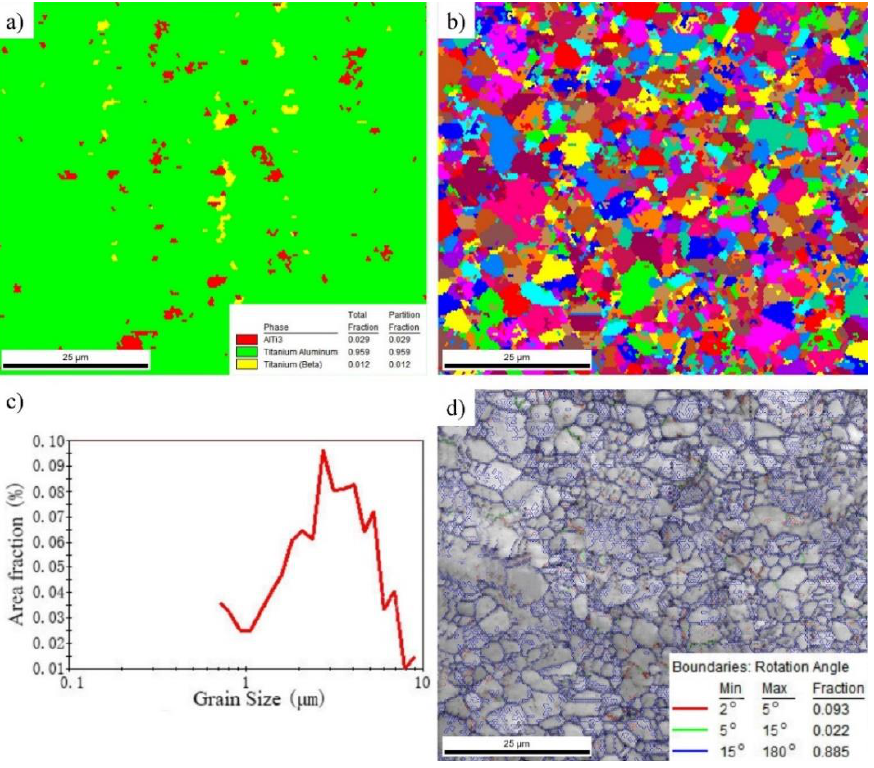
Figure 8. Electron back-scattered di ff raction (EBSD) maps of the Ti–43Al–3Mn–2Nb–0.1Y billet. ( a ) Phase composition, ( b ) grain distribution, ( c ) grain size, and ( d ) grain boundary feature.